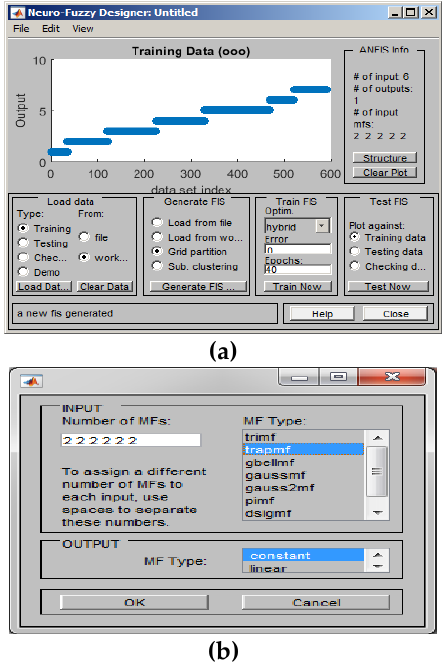
Figure 7. ANFIS Design Procedure. ( a ) Loading of training data set; ( b ) selection of ANFIS structure.